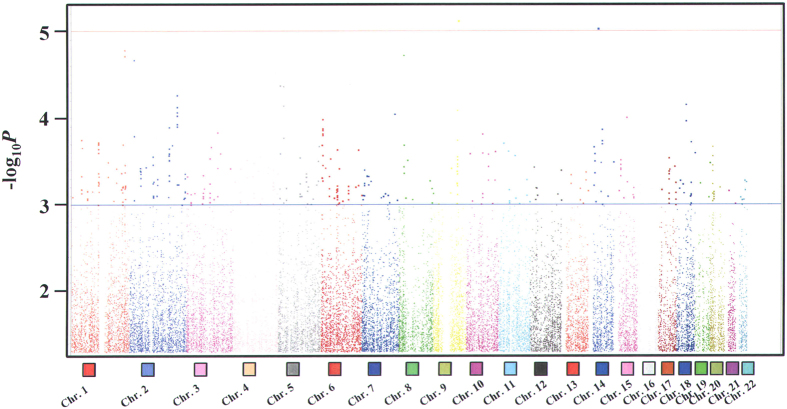
Genome-wide screening results.Manhattan plot for the SNPs on autosomal chromosomes, obtained using the chi-square test under a dominant model. The red and blue horizontal lines indicate the threshold of the genome-wide screen (p < 1 × 10−5) and the cutoff level for the top 203 SNPs used for the following functional studies (p < 0.005), respectively.